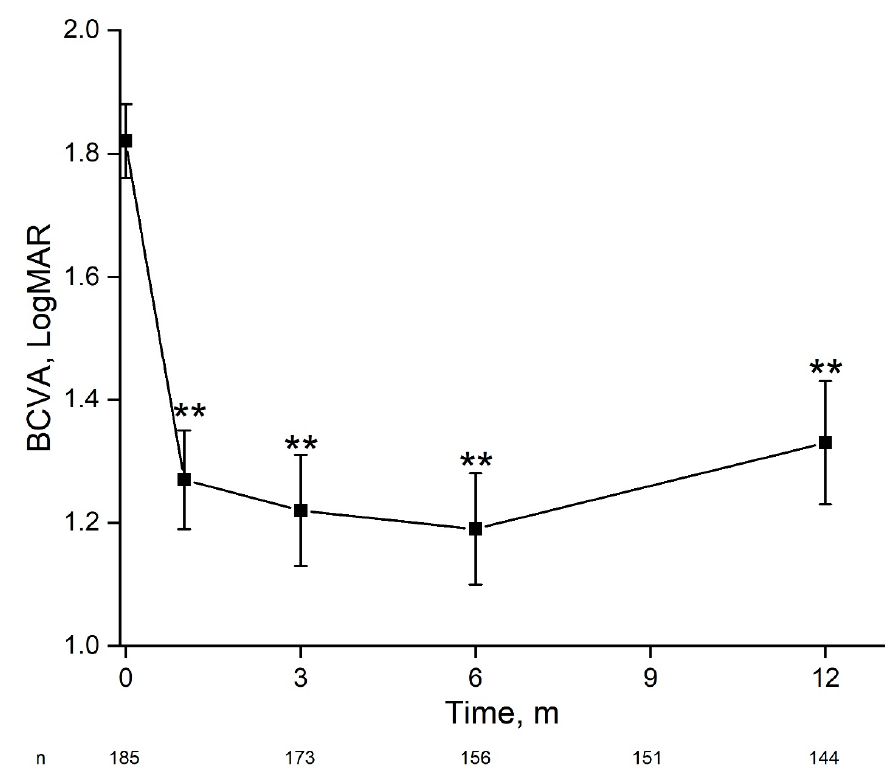
Figure 1. Change in visual acuity during 12 months following acute endophthalmitis. For the entire cohort, there was a significant and stable improvement in best-corrected visual acuity within one month. BCVA—best-corrected visual acuity, m—months. **— p < 0.01 (one-way